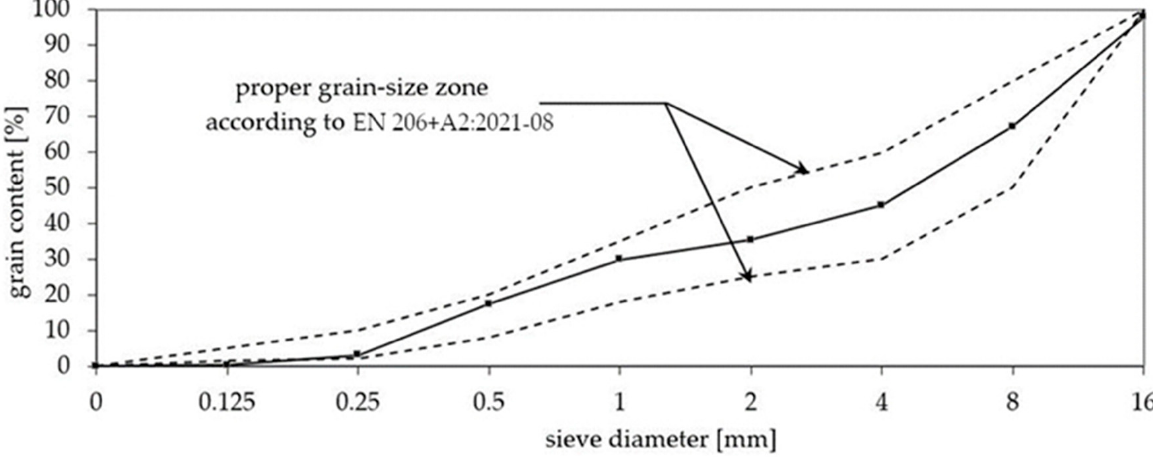
Figure 1. Particle size distribution of AACs.